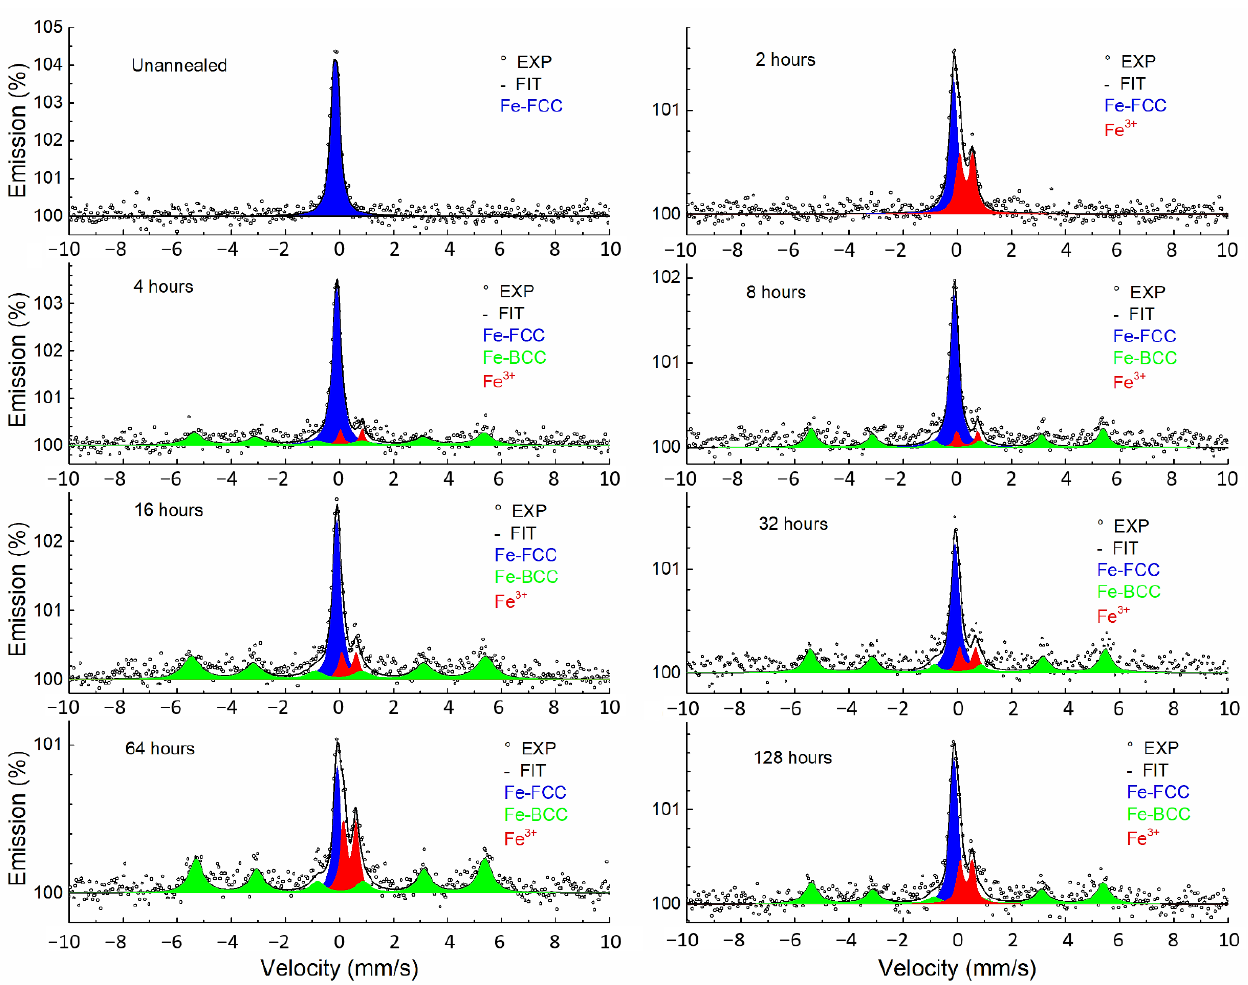
Figure 7. Conversion electron Mössbauer spectra of annealed samples.